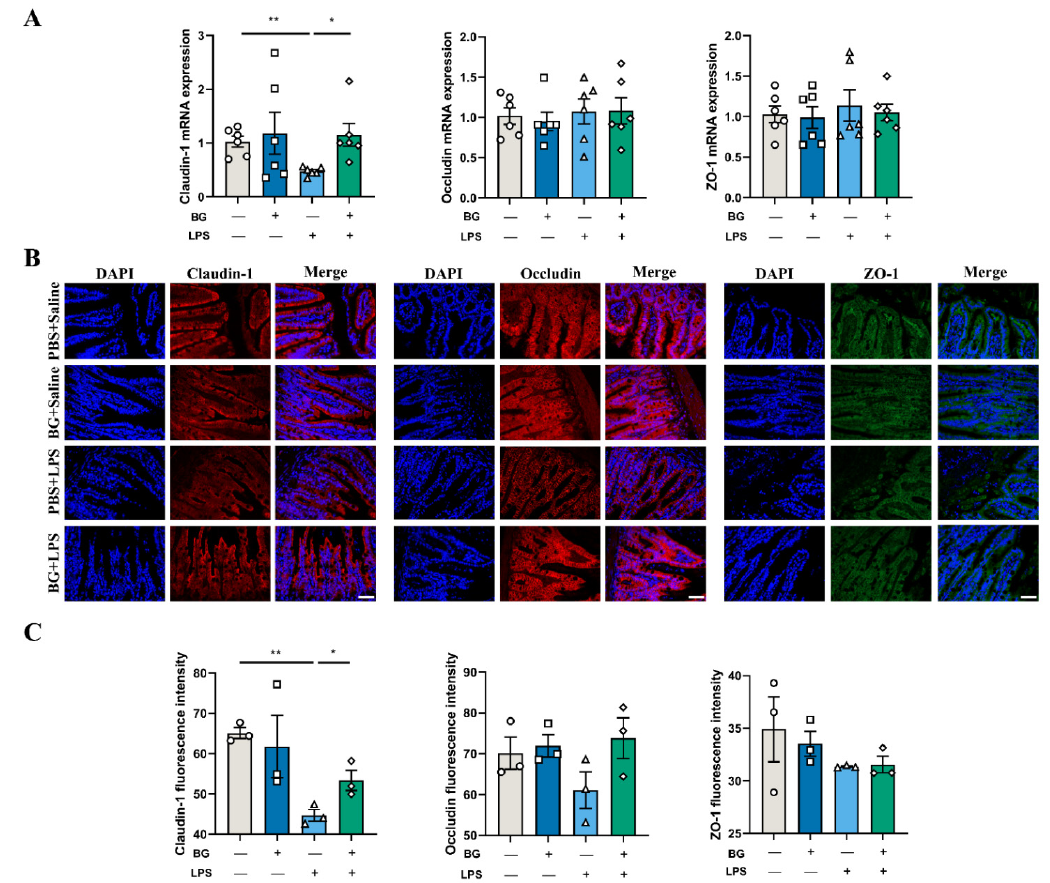
Figure 6. BG alleviated the reduction of tight junction protein expression in the ileum due to LPS induction. ( A ) The mRNA expression of tight junction proteins in the ileum. ( B ) The immunofluorescence images of claudin-1 (red), occludin (red), ZO-1 (green) and DAPI (blue) in the ileum. Scale bar: 50 μ m. ( C ) The fluorescence intensity of claudin-1, occludin and ZO-1. PBS+Saline, mice administered PBS, and injected with saline; BG+saline mice administered 1.5 g/kg BW BG and injected with saline; PBS+LPS, mice administered PBS and injected with LPS; BG+LPS, mice administered 1.5 g/kg BW BG and injected with LPS. “+” and “ − ” mean with and without corresponding treatments, respectively. Data are presented as mean ± SEM. * and ** indicate significant difference ( p < 0.05 and p < 0.01, respectively). An unpaired t -test was used for statistical analysis between two groups.